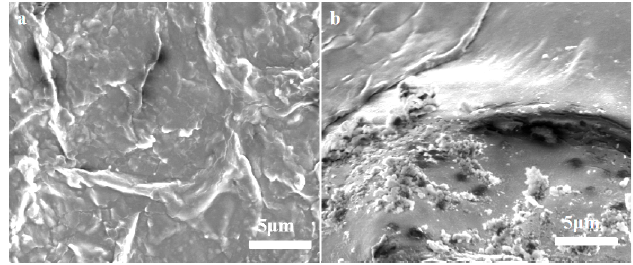
Figure 9. SEM images of ( a ) the LC/PLA nano ‐ delivery system and ( b ) the commercial LC SC on cucumber leaves.